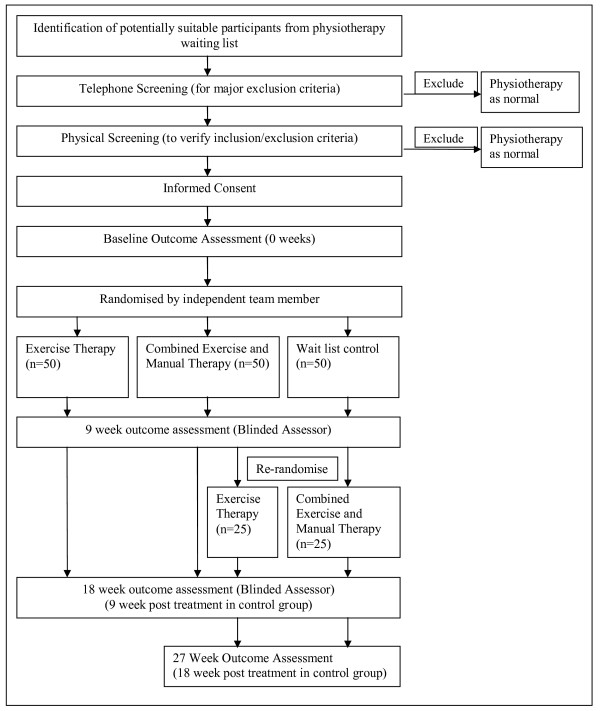
Flow of participants through the RCT.